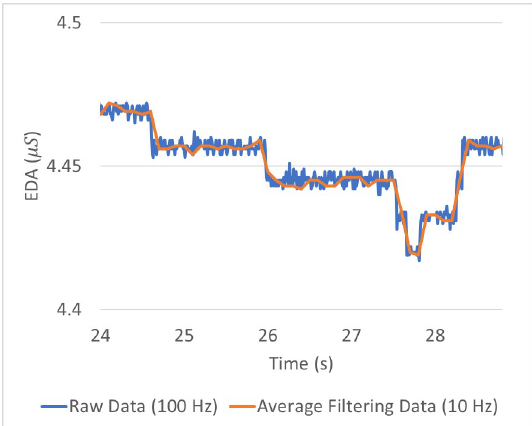
Figure 8. Part of raw and average filtering data of measuring EDA electrical conductance while one of simulation